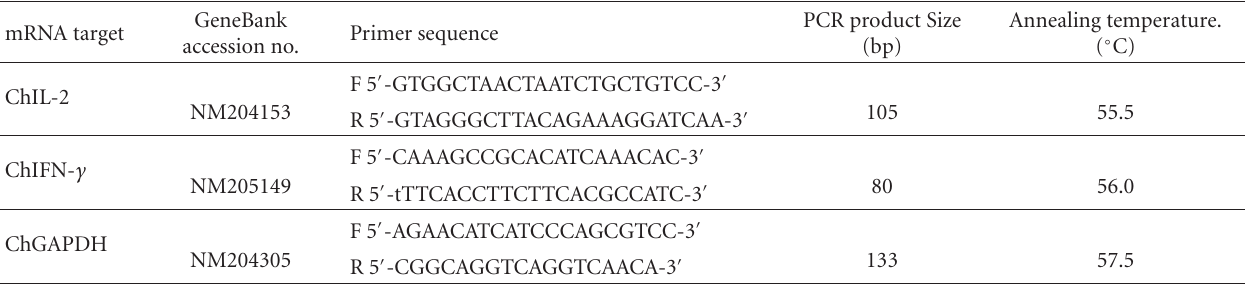
Table 2: Primer sequences and PCR conditions. The oligonucleotides were used to analyze the relative expression level of ChIL-2 and ChIFN- γ